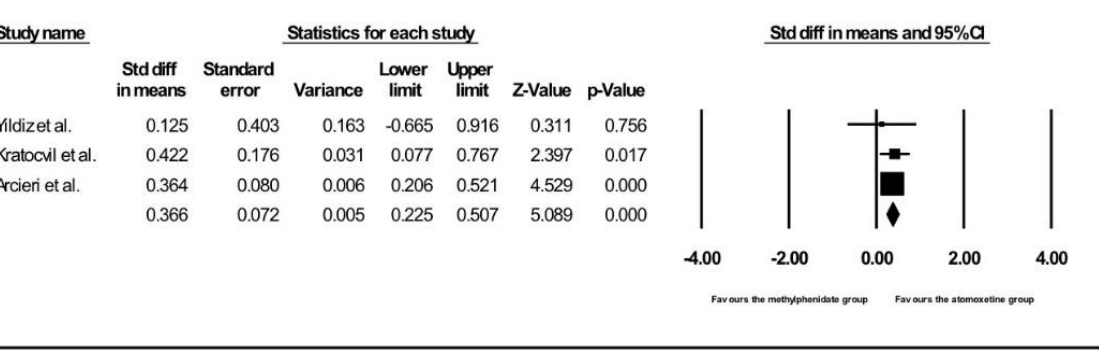
Figure 5. Forest plot of methylphenidate versus atomoxetine on post- vs. pre-treatment SBP in children and adolescents.